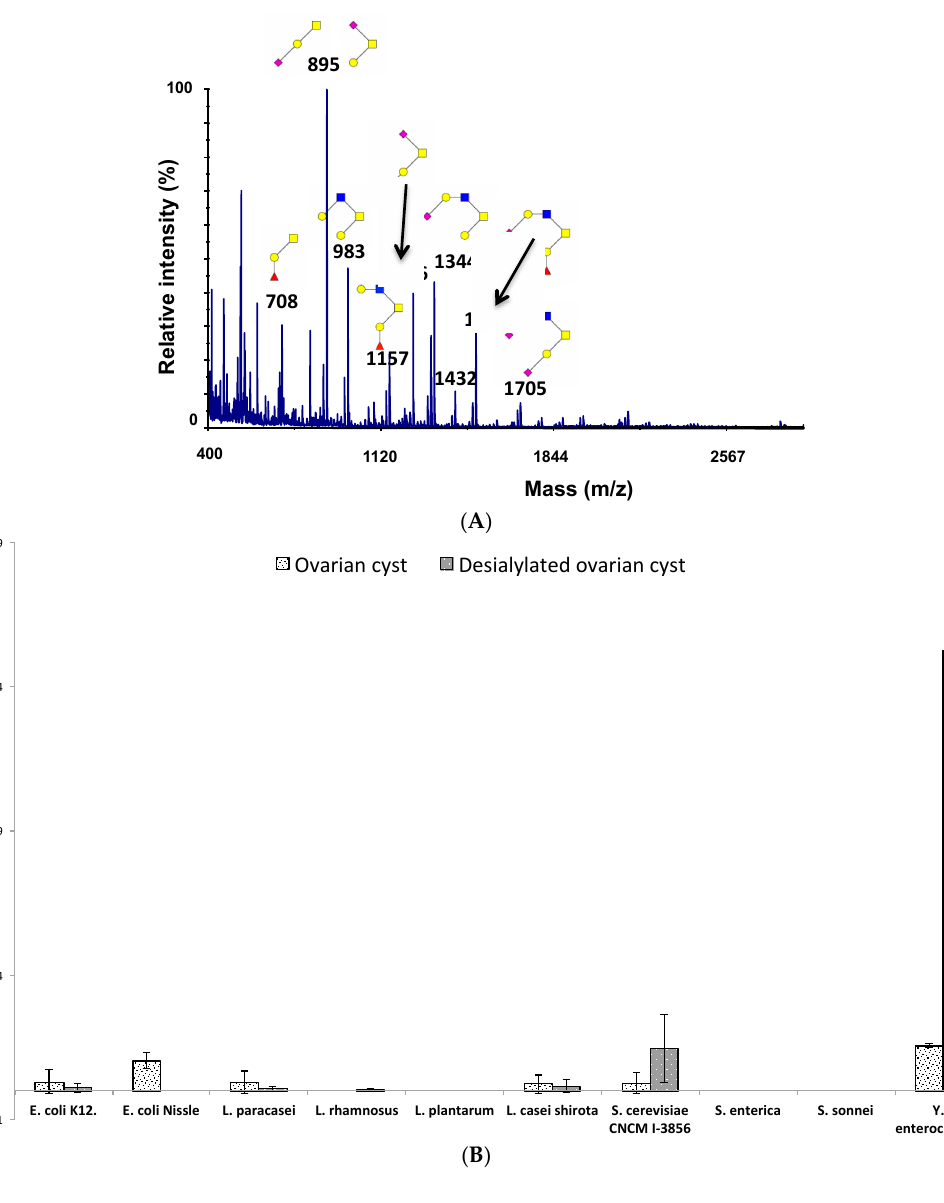
Figure 6. Not all types of sialylated mucin O -glycans are ligands for microorganisms. ( A ) MS spectrum of permethylated O -glycans isolated from human malignant ovarian cyst mucins, acquired in the positive ion mode [M+Na] + . Monosaccharide symbols are used according to the Consortium for Functional Glycomics (CFG) nomenclature. Key: fucose (red triangle), GlcNAc (blue square), sialic acid (purple diamond), galactose (yellow circle), GalNAc-ol (yellow square) and sulfate residue (S). ( B ) Binding of DAPI-labeled microorganisms to human purified native ovarian cyst mucins (white, black dots) and their desialylated counterparts (dark grey, white dots) was quantified by slot-blot overlay assays. Sialic acid residues from ovarian cyst mucin O -glycans were not recognized by microorganisms. Chemical desialylation of ovarian cyst mucins significantly increased the binding of Y. enterocolitica . Data shown is a representative experiment ± SD of three replicates.